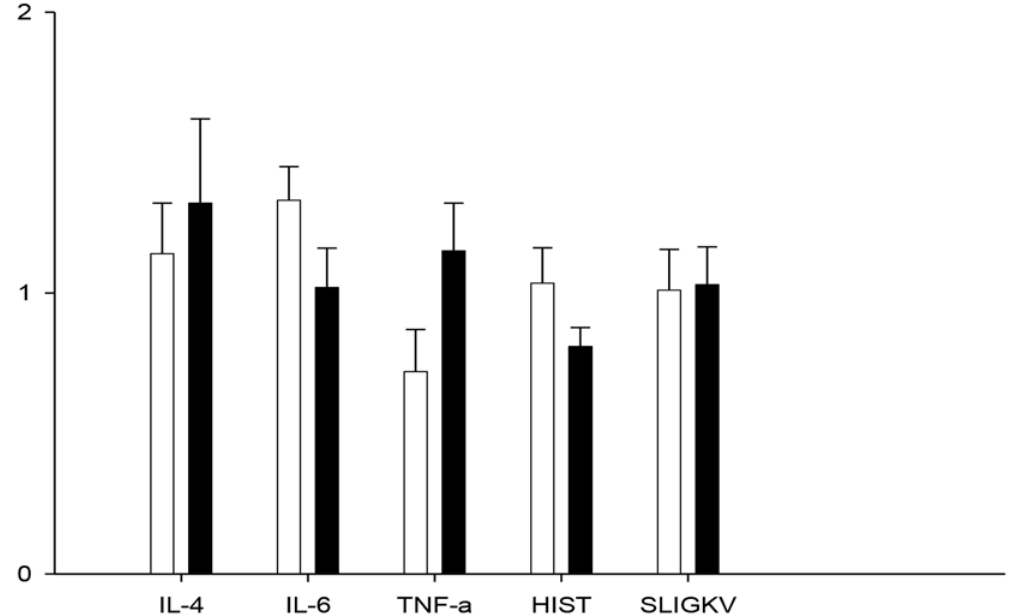
Fig 2. Proliferation of neonatal and adlult cultured human airway smooth muscle cells in the presence of pro-inflammatory stimuli. Results are means ± SEM. Values were normalized to proliferation in ITS medium. Cells cultured in 100 ng/ml IL-4 (black bars, adults; white bars, neonates)), IL-6, TNFalpha or 10 -4 M Histamine, SLIGKV were assayed 24 following synchronization in ITS medium. There were no significant difference between the 2 age groups regarding all experimental conditions (N = 3 to 6 per group, Mann-Whitney